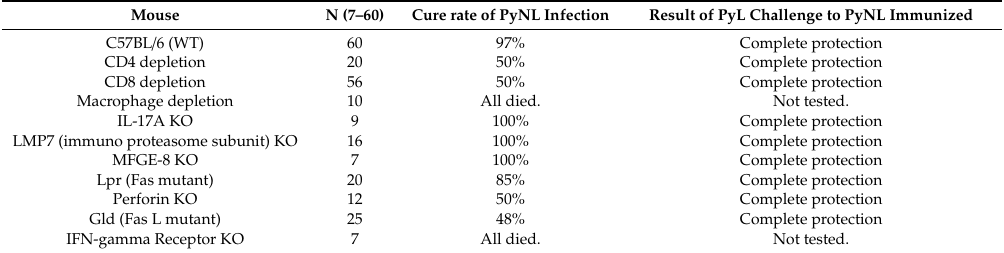
50% Complete protection Gld (Fas L mutant) 25 48% Complete protection IFN-gamma Receptor KO All died. Not Table 1. Cross-strain protection by PyNL infection followed by PyL challenge in immunodeficient mice. Cure rate of PyNL Mouse N (7 – 60) Infection